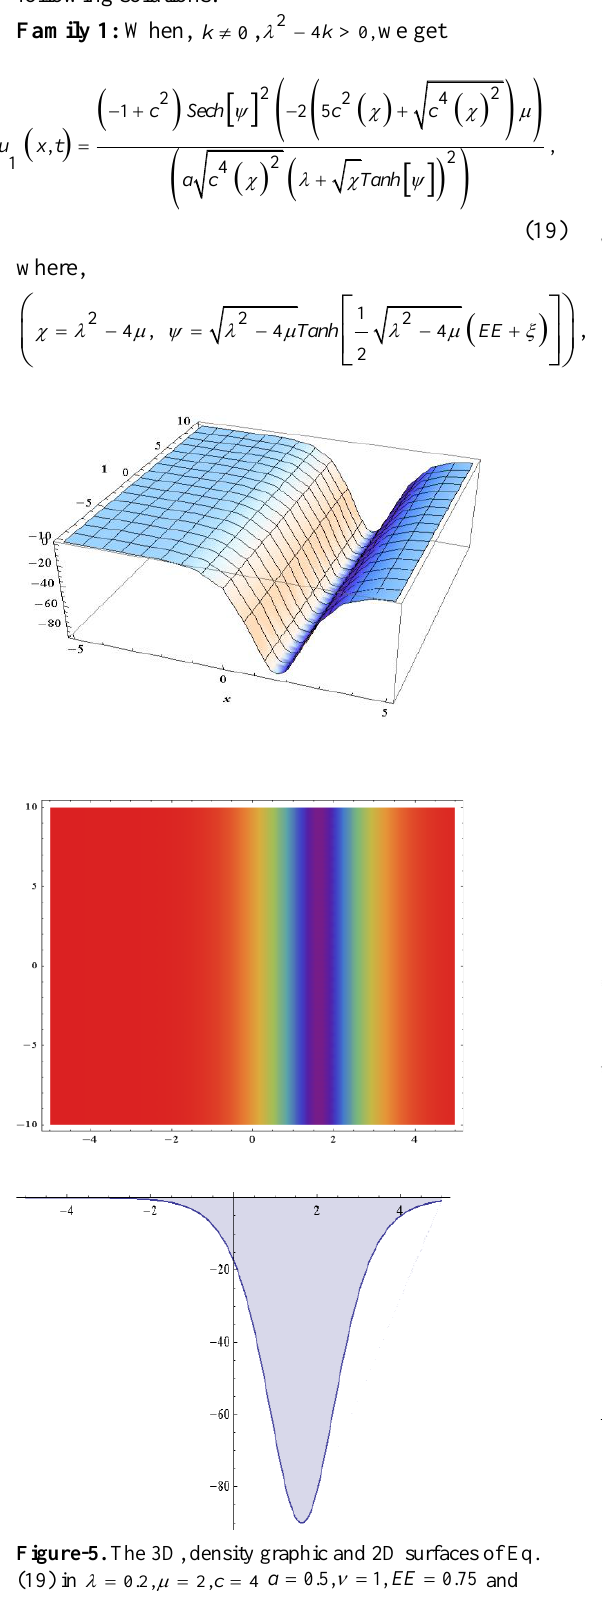
Figure-5. The 3D, density graphic and 2D surfaces of Eq. (19) in 0.2, 2, 4 c  = = = 0.5, 1, 0.75 a EE = = = and 1 t = .